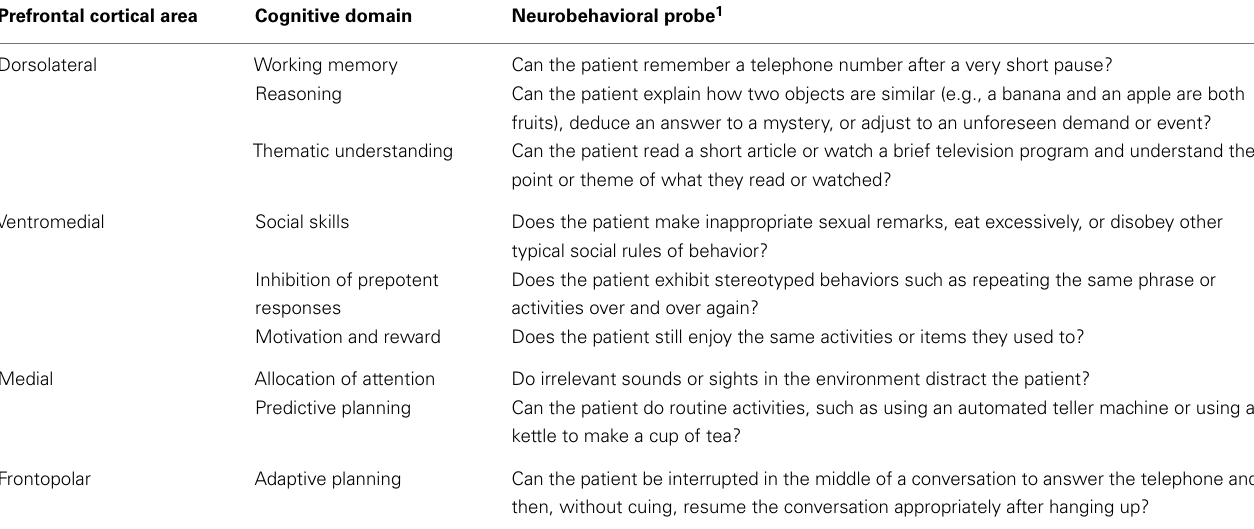
Table 1 | Functional and anatomical divisions of the prefrontal cortex adapted from Grafman and Litvan